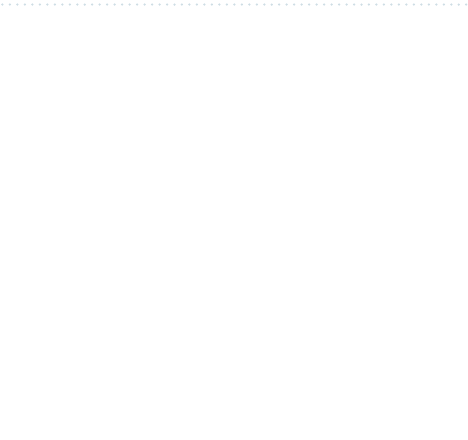
Figure 2. Transversal (top) and longitudinal (bottom) views of the (10, 10) armchair and (14, 0) zigzag blue PNTs in ( a , b ), respectively.